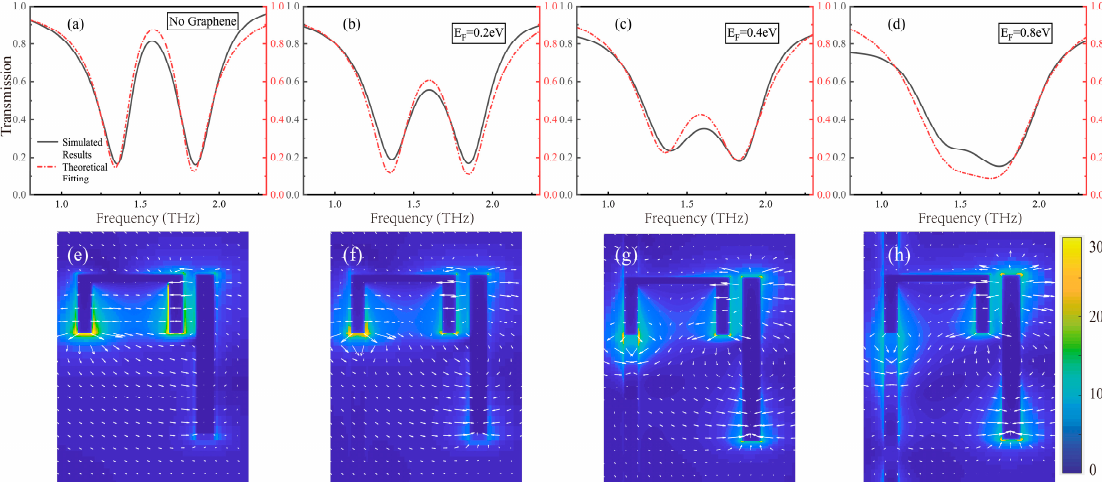
Figure 4. ( a – d ) Transmission spectrum of the proposed metamaterial structure at different Fermi levels of graphene and the corresponding theoretical fitting results. Correspondingly, the electric field distribution of the metamaterial substructure unit at a frequency of 1.6 THz when there is no graphene ( e ) and the graphene Fermi level is 0.2 eV ( f ) 0.4 eV ( g ) and 0.8 eV ( h )